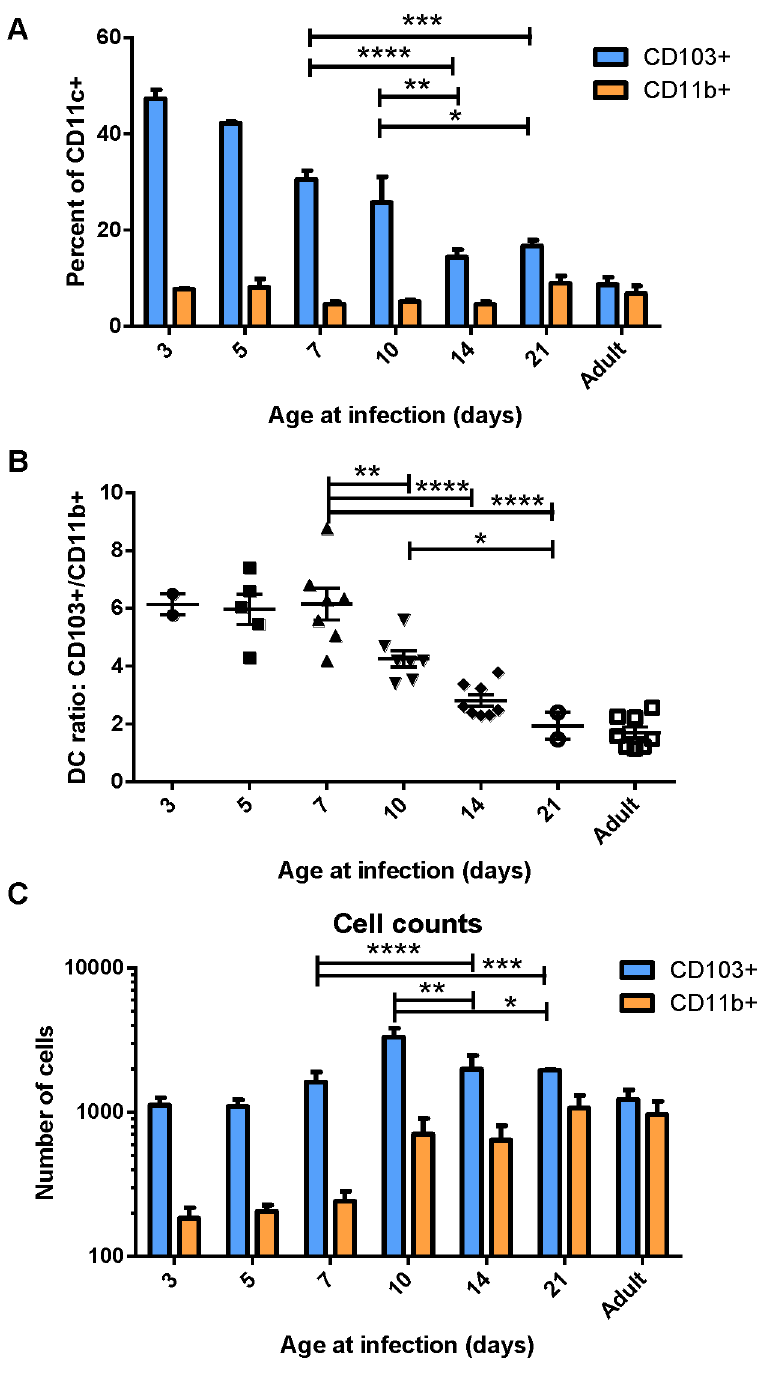
Figure 2. Lung-migratory dendritic cell responses change dramatically during early life. CD103 + and CD11b + DC populations in the MLN three days post-RSV infection were measured in mice of different ages. A) DC populations as a percent of CD11c + -gated cells of mice infected at the indicated age. B) Ratio of CD103 + to CD11b + cells in the MHC Class II high gate. C) Total number of DC cells acquired on the flow cytometer per mouse after running samples to completion. Data in A and C are representative of three experiments using mice at available ages, and B represents data compiled from three independent experiments. Groups were compared using a two-way or one-way ANOVA and Tukey’s multiple comparisons tests in GraphPad Prism and significant differences within the 7–21 day transition period are indicated (* p # 0.05, ** p # 0.01, ***p # 0.001, **** p # 0.0001). Error bars represent the SEM. doi:10.1371/journal.ppat.1003934.g002 co-instillation of DQ ovalbumin (DQ-ova). DQ-ova is a self- adaptive T cell responses. Again, a lower frequency of CD103 + quenched conjugate that fluoresces upon proteolytic degradation, and CD11b + DCs from mice infected in early life were positive, a requisite for presentation of MHC/peptide and the induction of indicating that they had taken up and processed DQ-ova (Figure 3,